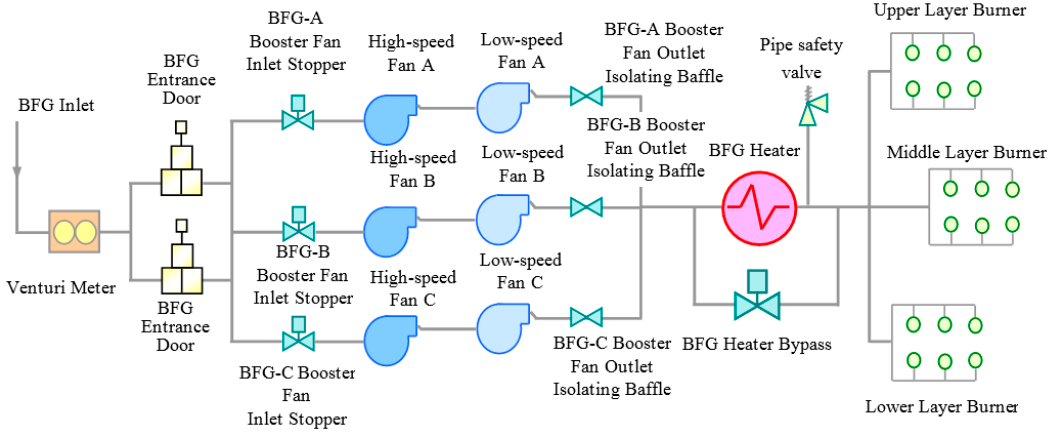
Figure 15. Schematic diagram of the BFG power plant.